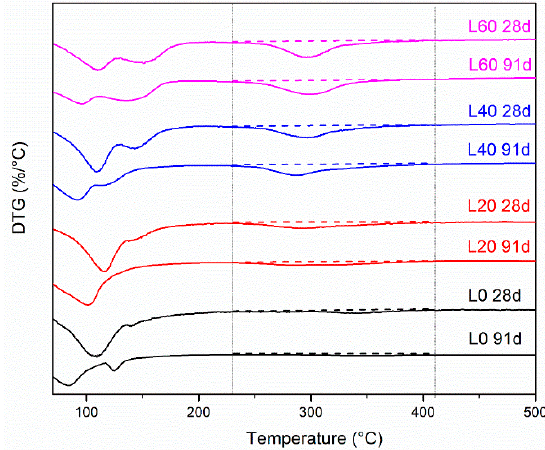
Figure 7. DTG showing Friedel’s salt peaks for group L mixtures as a function of time.